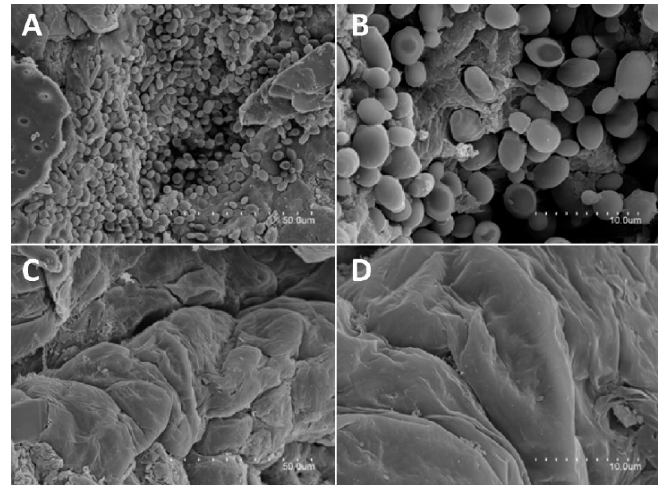
Figure 8. Scanning electron microscopy images of skin samples obtained from C. albicans -infected ( A , B ) and non-infected ( C , D ) mice. Images A and C were obtained using a 1100 × magnification and B and D using a 4000 ×